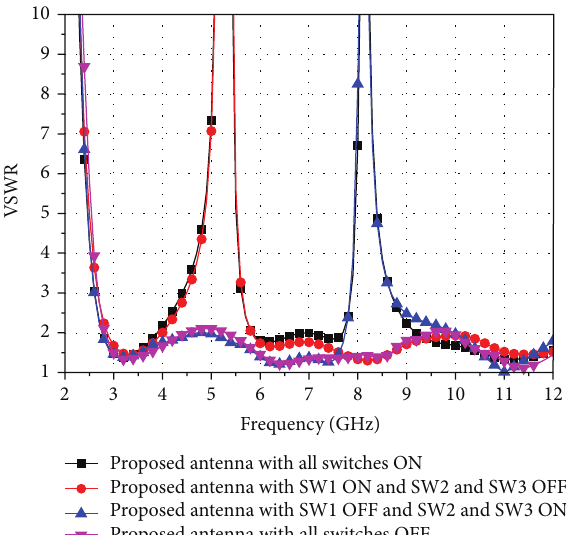
Figure 4: Reconfigurable characteristic of